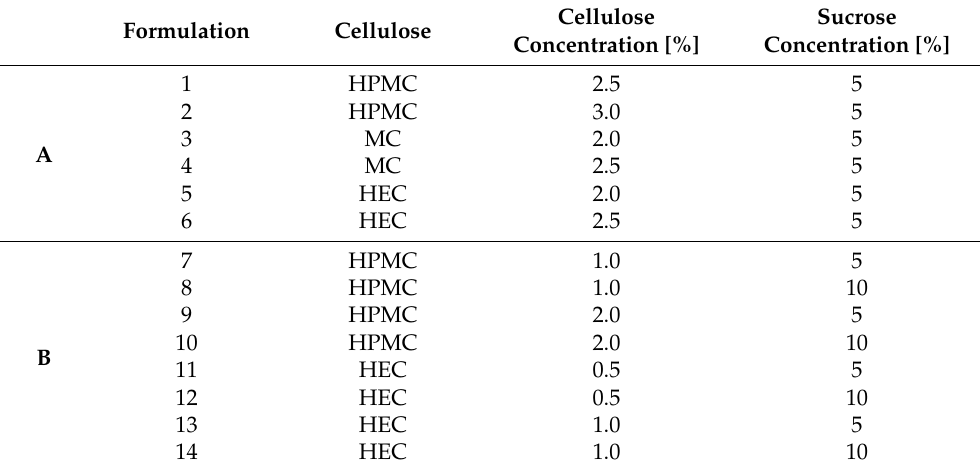
Table 3. Summary formulation approaches using different celluloses and various sucrose concentrations. Formulation Cellulose